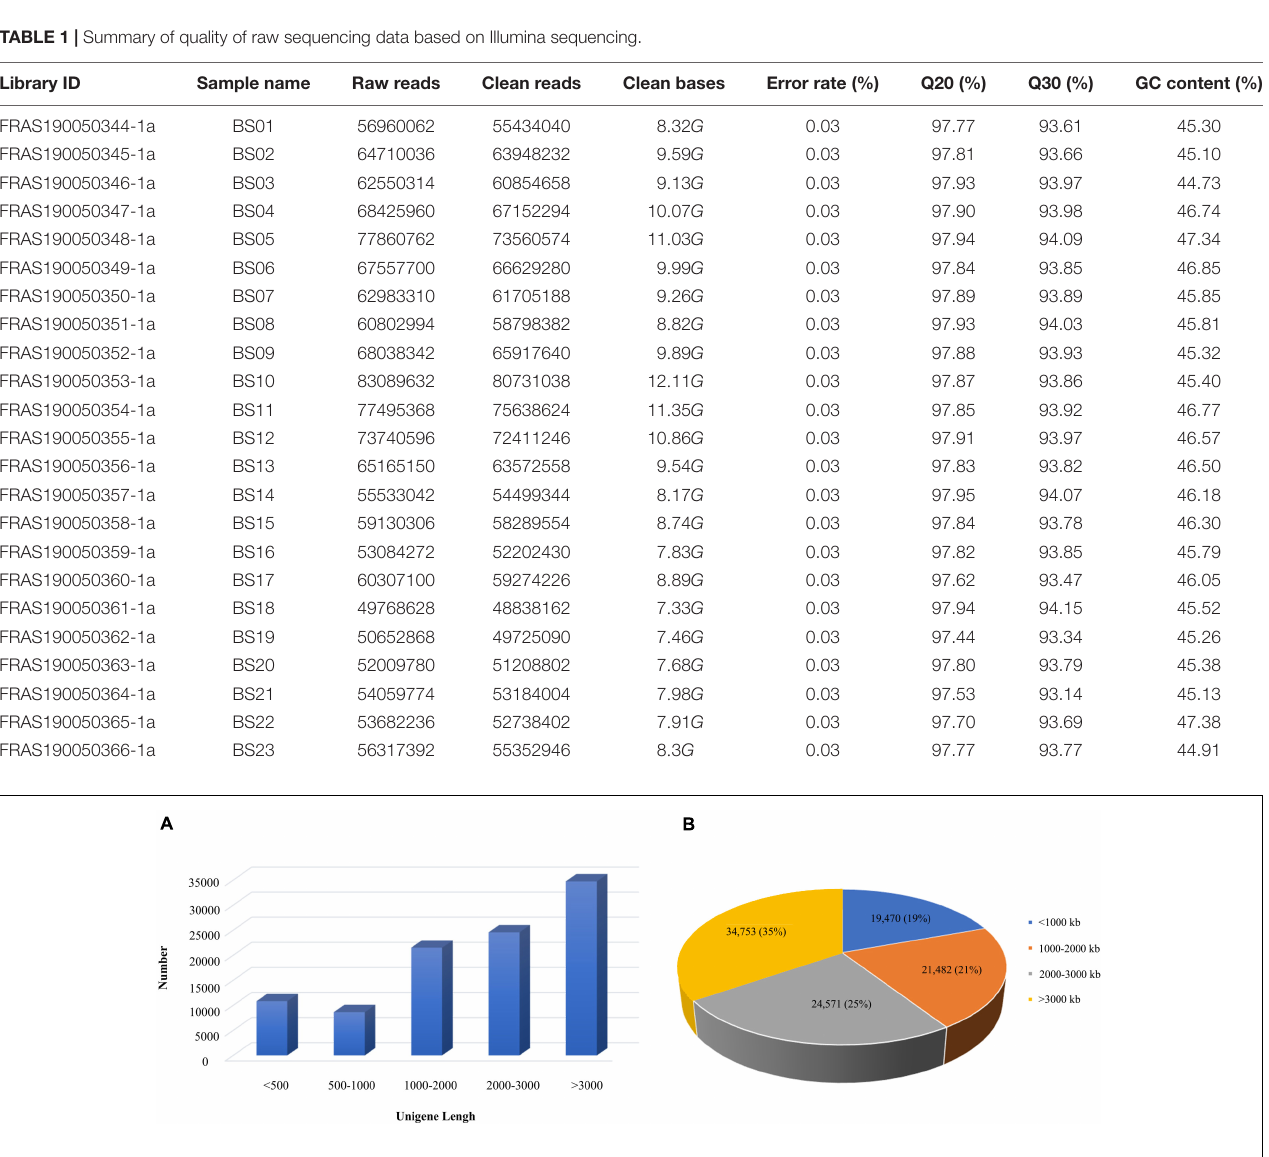
FIGURE 2 | Distribution map of transcripts length of B. striata . The blue area represents the number of transcriptomes less than 1000 bp, the orange area represents the number of transcriptomes in 1000–2000 bp, the gray area represents the number of transcriptomes in 2000–3000 bp, and the yellow area represents the number of transcriptomes less than 1000.